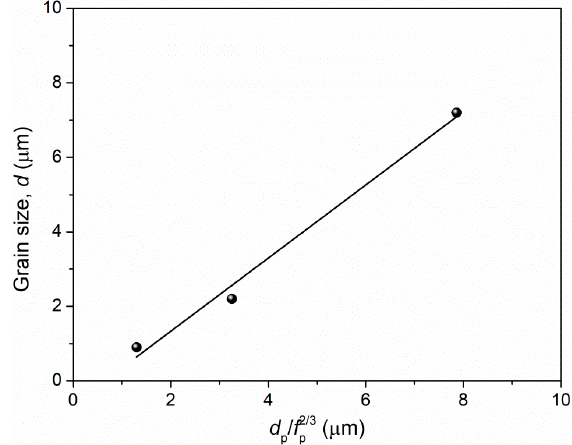
Figure 10. Relation between grain size and precipitate characteristics.